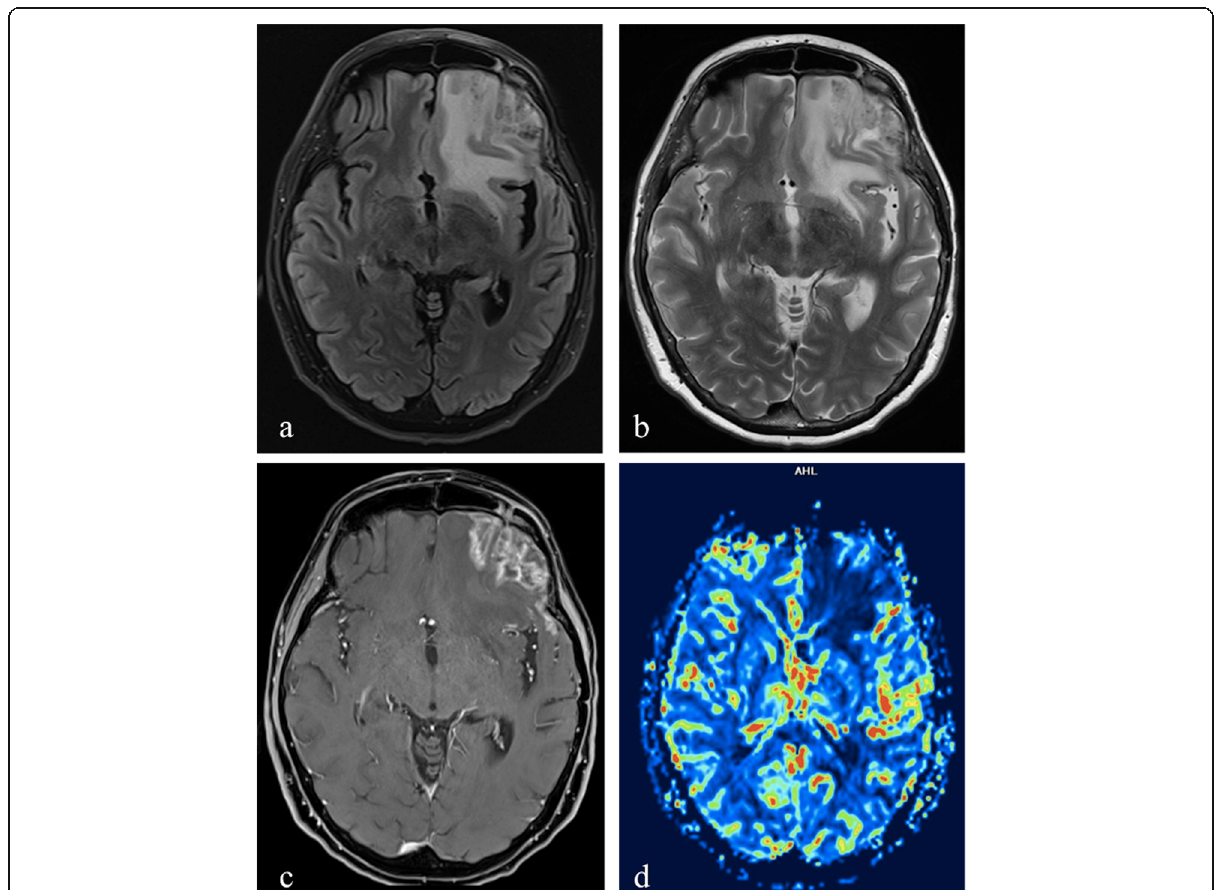
Fig. 5 MRI performed 5 years after proton-beam therapy for skull base chondrosarcoma. Axial FLAIR ( a ) and T2-weighted ( b ) images show a disomogenous hyperintense lesion, involving both gray and white matter, in left frontal lobe surrounded by wide edematous area extending to the external capsula and causing mild mass-effect on striatum nucleus and midline structures. Axial post-contrast T1-weighted image ( c ) shows disomogeneous enhancement with “ Swiss cheese ” pattern. rCBV map ( d ) demonstrates no hypervascularization within the enhanced